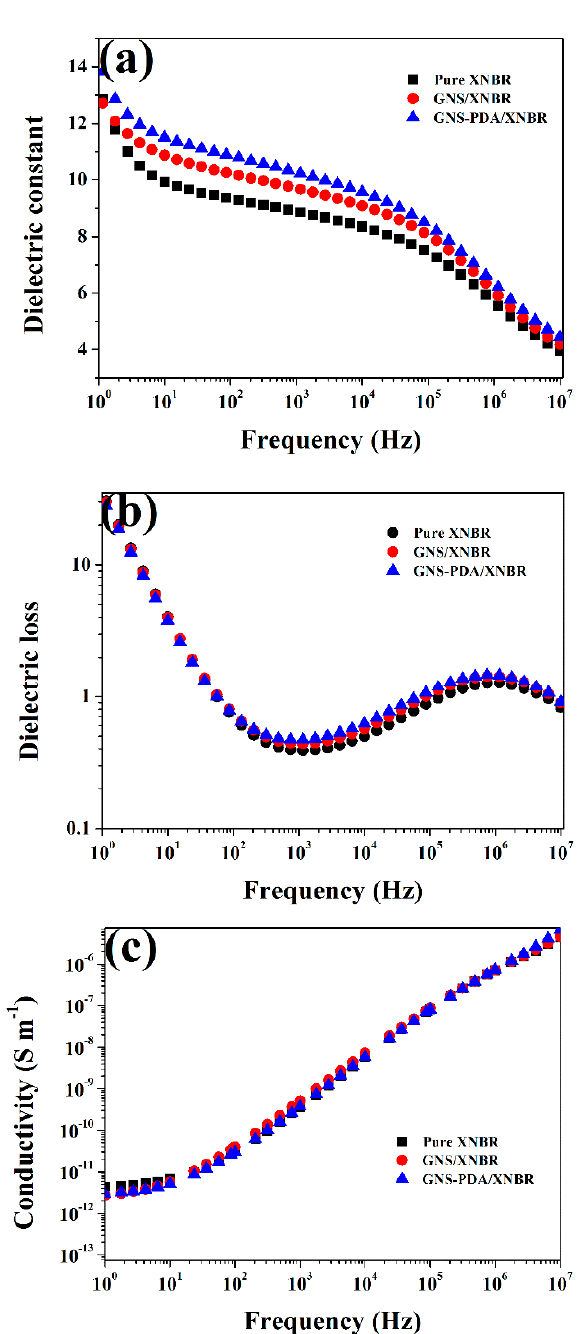
Figure 6. Dependence of ( a ) dielectric constant, ( b ) dielectric loss, and ( c ) AC electrical conductivity on frequency at room temperature for pure XNBR, GNS/XNBR composite, and GNS-PDA/XNBR composite.